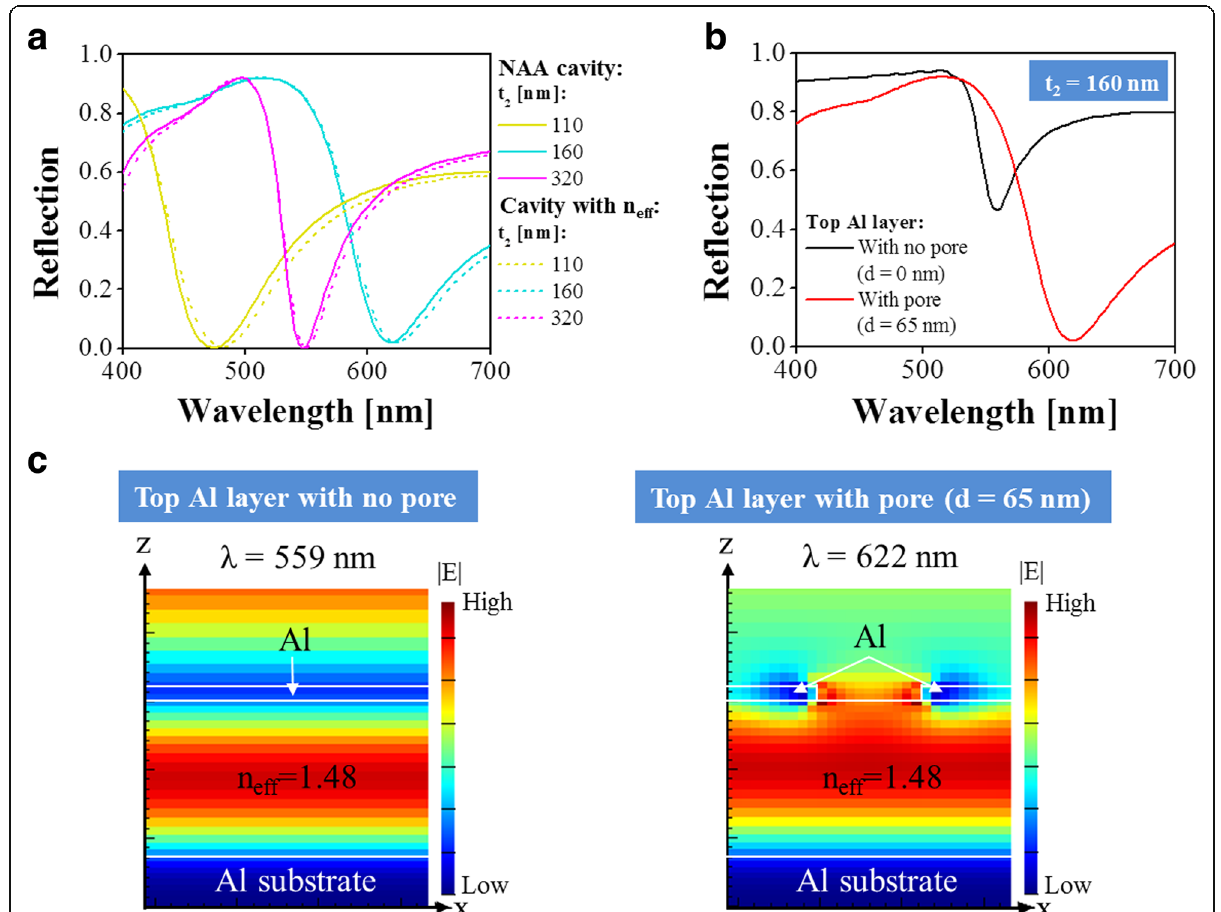
Fig. 6 a Simulated reflection spectra of the proposed structure based on the NAA cavity and the equivalent structure based on a homogeneous cavity with effective refractive index ( n eff ) for different cavity thicknesses of t 2 =110, 160, and 320 nm. b Simulated reflection spectra of the structures including the top Al layer without pore and with pore ( d =65